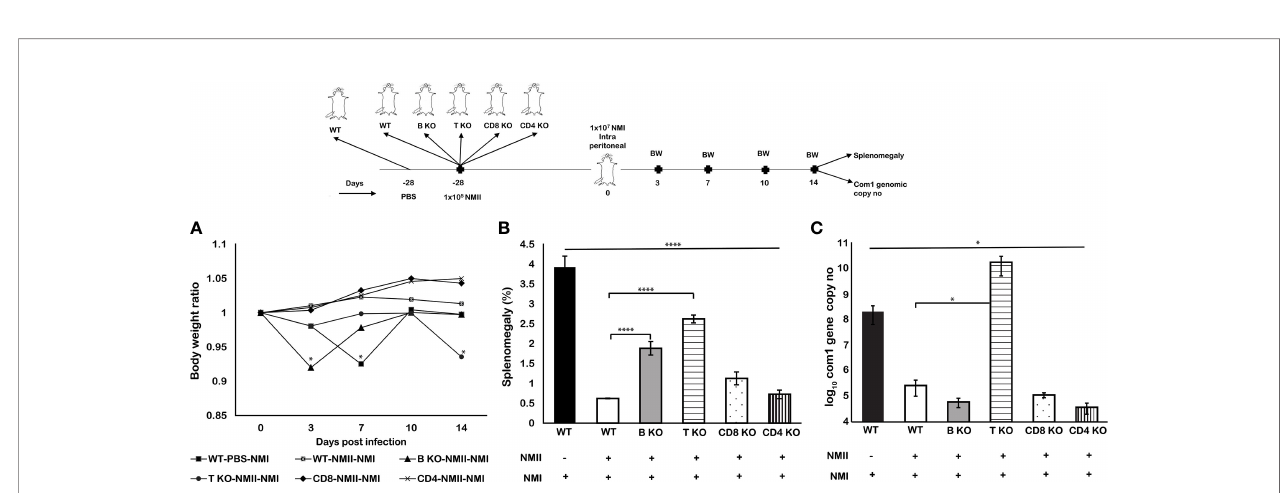
FIGURE 10 | Viable NMII bacteria induced partial protection in B cell and T cell knockout mice against virulent NMI challenge. C57BL/6J wild-type (WT) and B cell-, T cell-, CD4 + T cell-, or CD8 + T cell-de fi cient mice were IP immunized with 10 5 GE of viable NMII and IP-challenged with 1 × 10 7 GE of NMI at 28 dpv. Additionally, PBS-immunized WT mice were IP challenged with 1 × 10 7 GE of NMI served as unimmunized controls. Body weight ratio (A) , splenomegaly [ (B) , % of spleen weight/body weight], and bacterial burden (log 10 C. burnetii com1 gene copy numbers) in the spleen (C) were evaluated at 14 dpi. Each experimental group includes four mice, with error bars representing the standard deviations from the means. *p < 0.05; ****p < 0.0001, as determined by Welch t test using GraphPad.